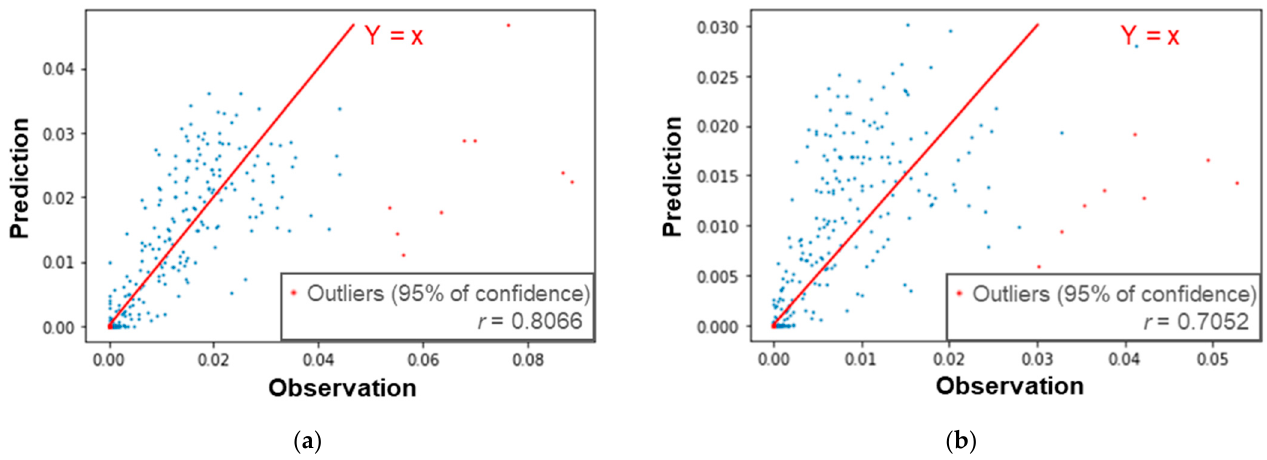
Figure 13. Spatial evaluation of forest fire frequency simulated by the optimized FLAM: ( a ) period A from January 2016 to December 2019, ( b ) period B from January 2020 to March 2022.